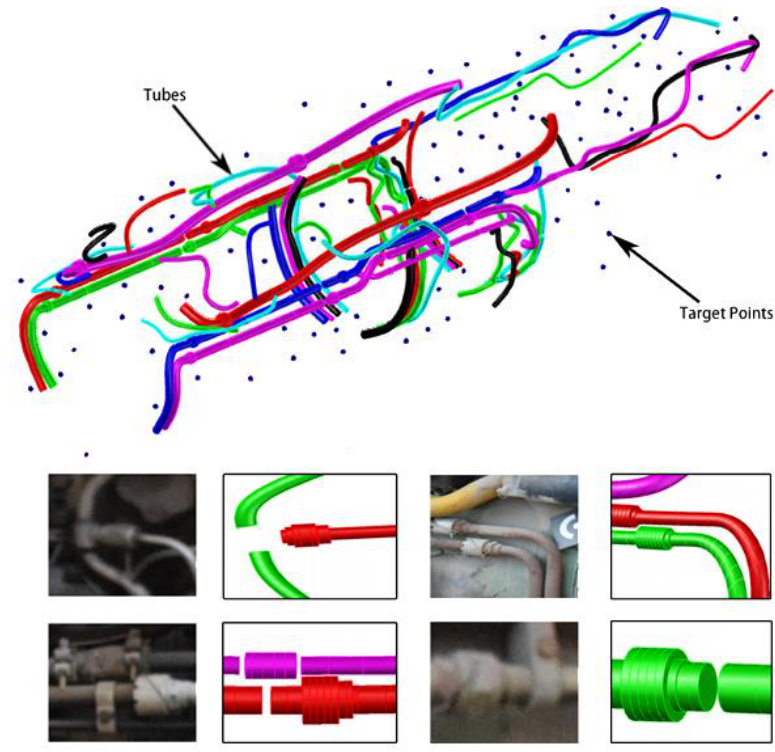
Figure 16. Complex tube system construction result.